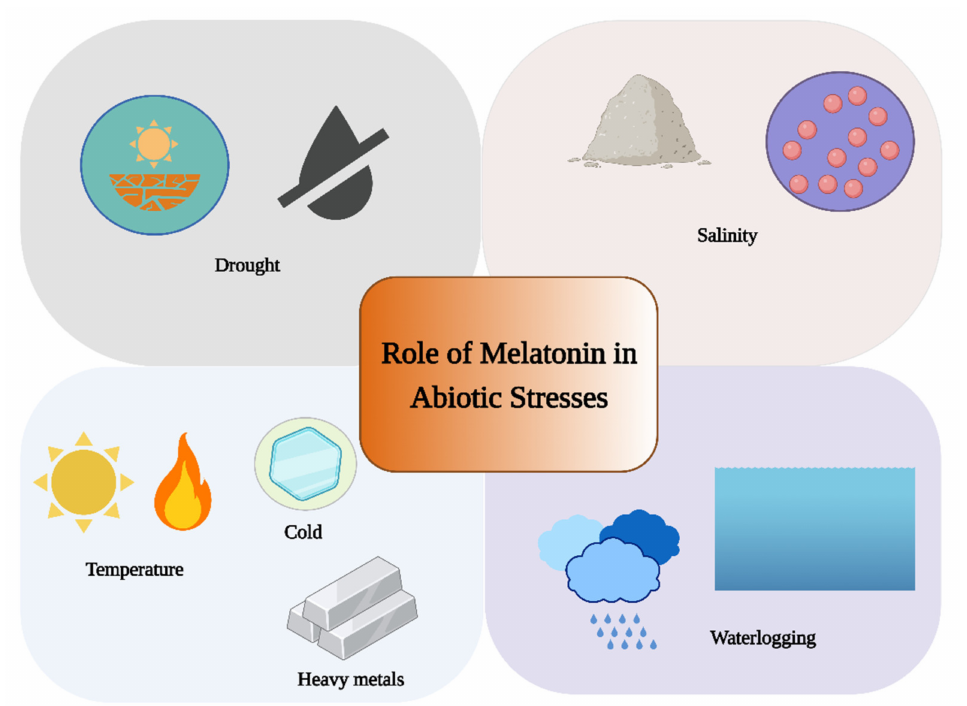
Figure 3. Role of melatonin under abiotic stress. This figure was created with BioRender.com (accessed on 7 September